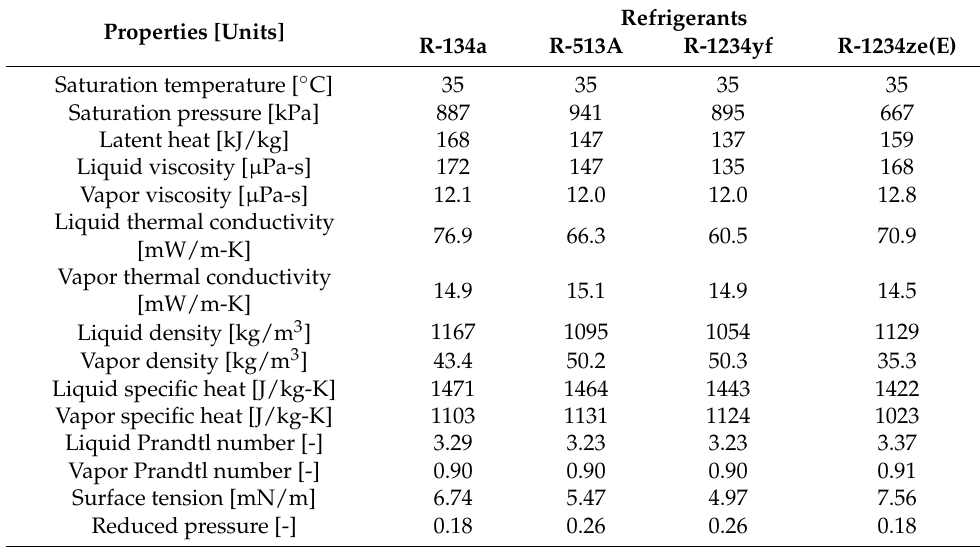
Table 4. The thermodynamic and transport properties of R-134a alternative refrigerants